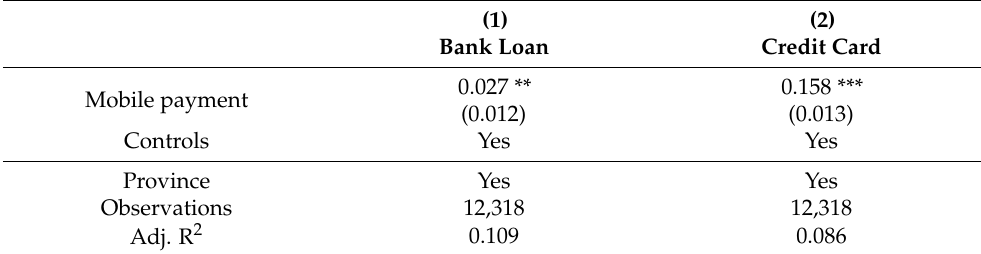
Table 9. Mechanism analysis: easing liquidity constraints.